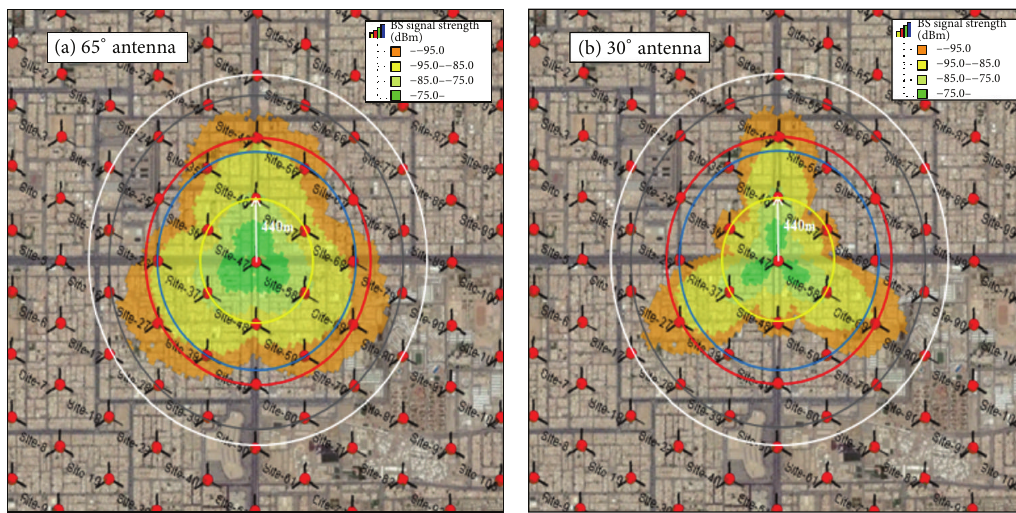
Figure 1: RF coverage of serving trisector BS (site-58) for the sector in the direction of the arrow for 𝑓 𝑐 = 28 GHz and various TX antenna beamwidths: (a) 65 ∘ , (b) 30 ∘ .